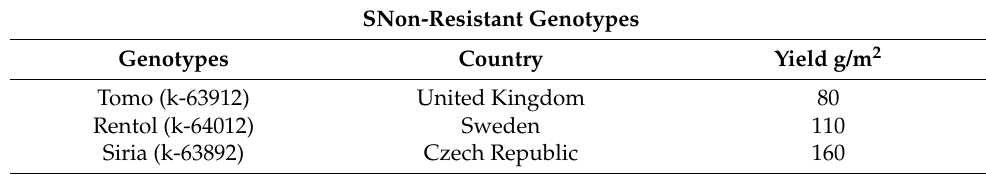
Table 10. Yield of the nonresistant genotypes